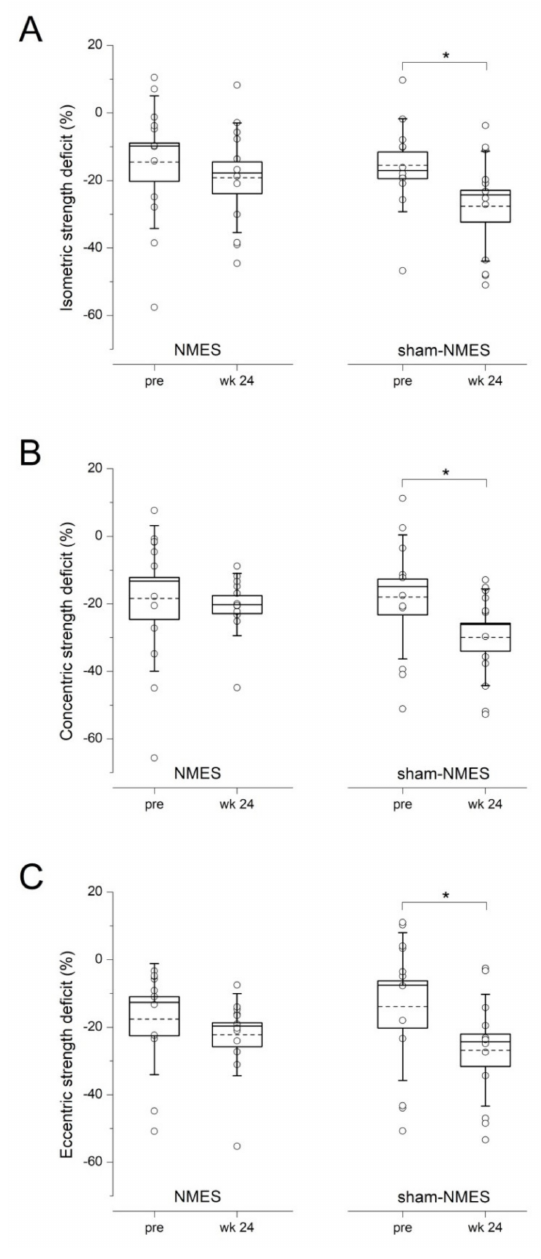
Figure 3. Isometric ( A ), concentric ( B ), and eccentric ( C ) knee extensor strength deficits at pre and week 24 in the NMES and sham-NMES groups. The box represents the standard error, the horizontal lines within the box represent the median and the mean, and the whiskers represent the standard deviation (single data are also shown). * p <